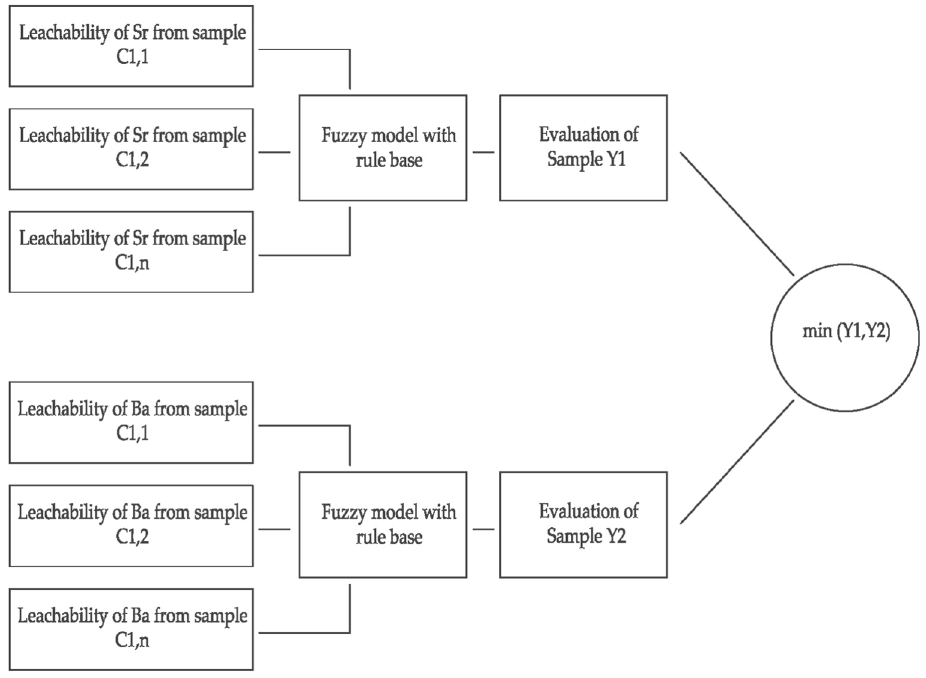
Figure 4. General scheme of fuzzy inference of the elution of Sr and Ba from opoka rock.